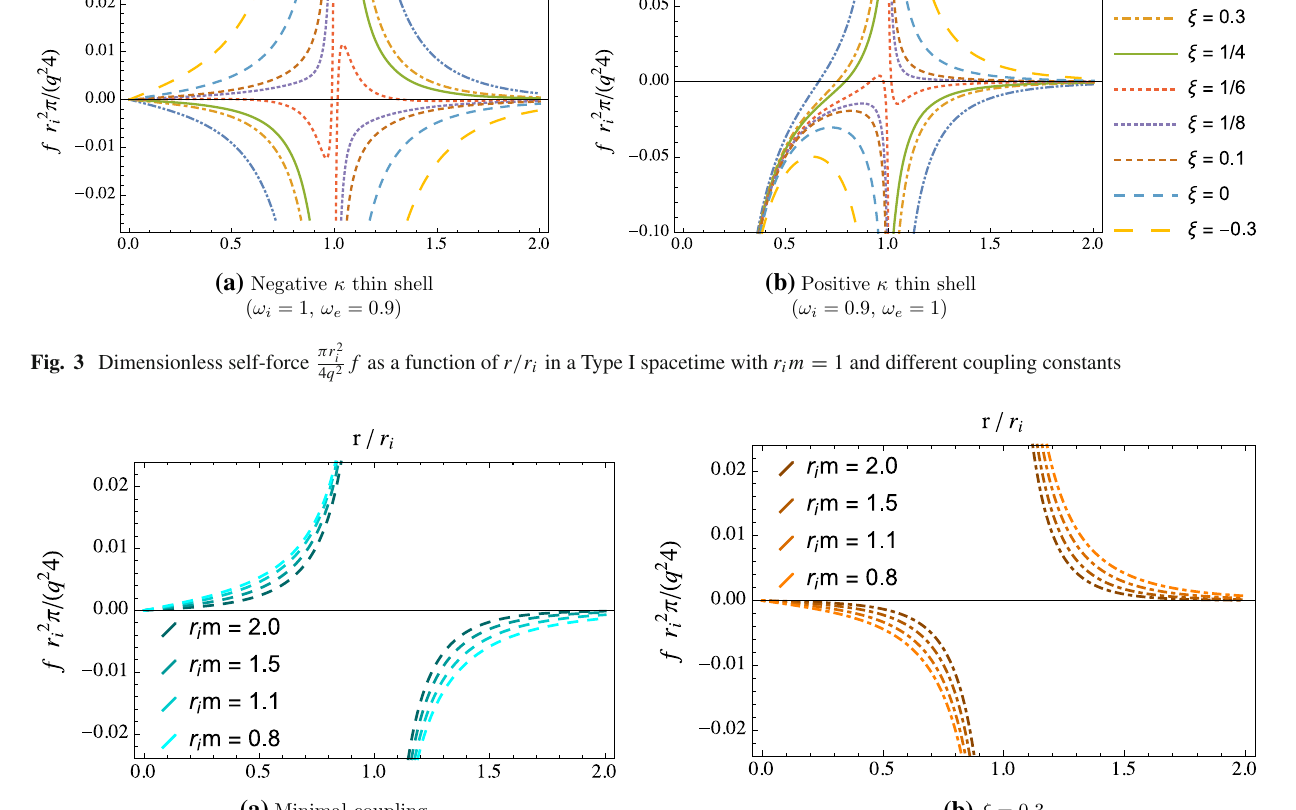
Fig. 4 Dimensionless self-force